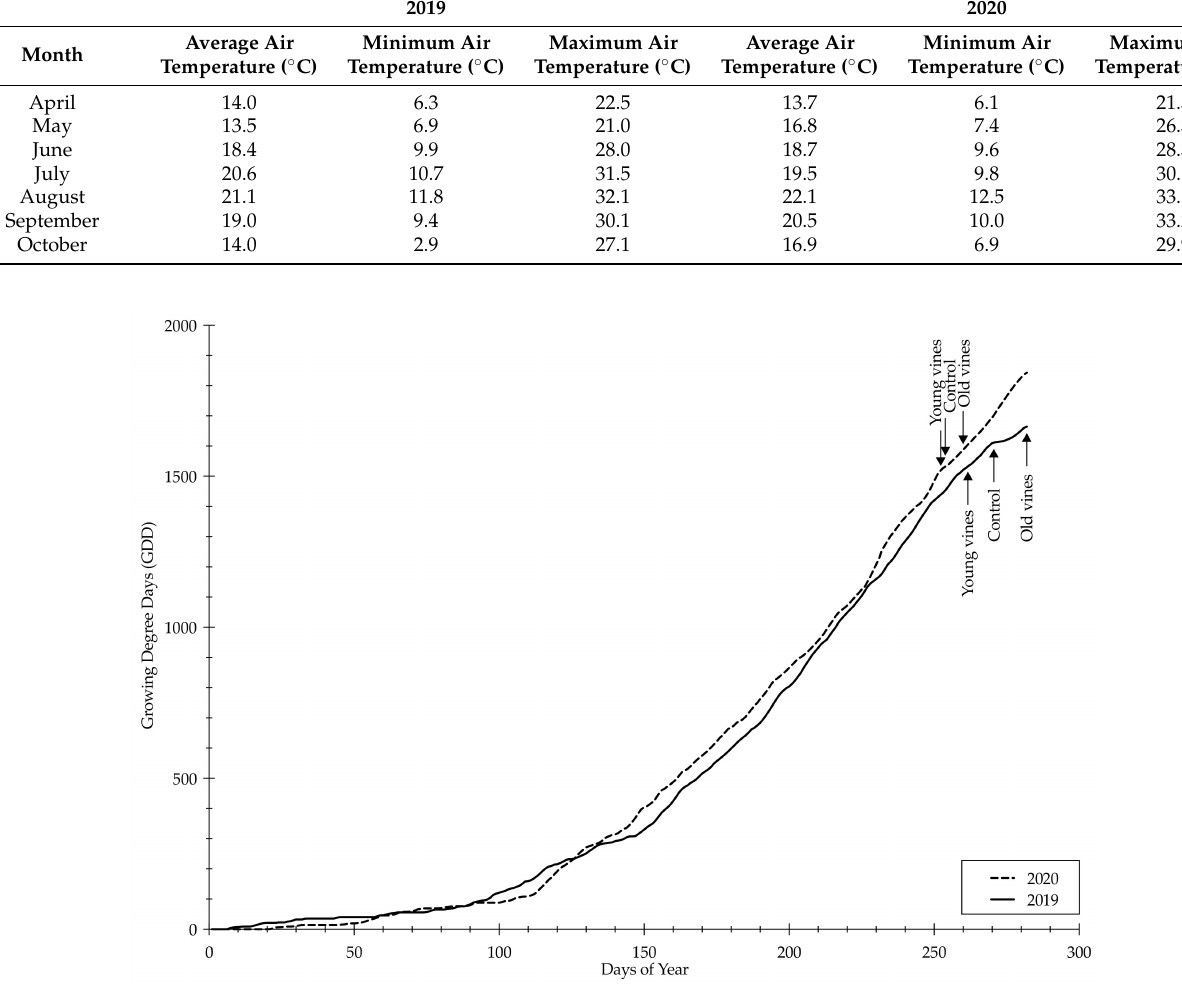
Figure 1. Growing degree days (GDD) accumulation for Atascadero, California weather station 163 during the 2019 and 2020 growing season. Harvest dates for each treatment marked with an